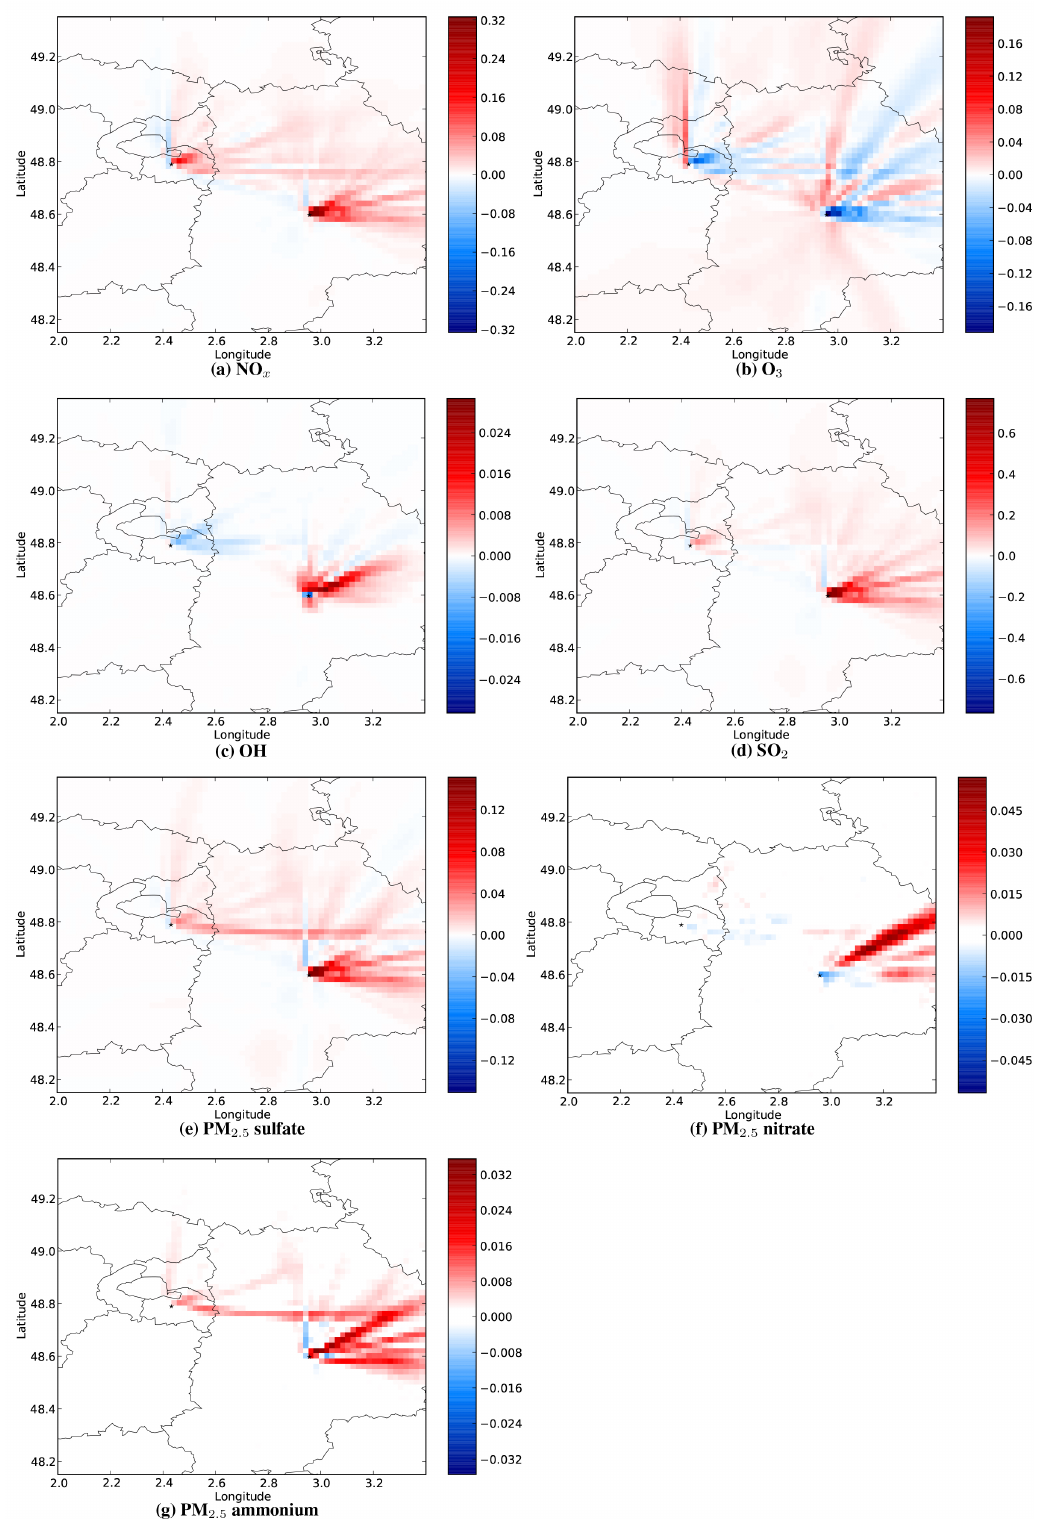
Fig. 4. Differences (PinG – Reference) in mean surface concentrations for 4–29 July 2009 over the Greater Paris domain: (a) NO x (ppb), (b) O 3 (ppb), (c) OH (ppt), (d) SO 2 (ppb), (e) PM 2 . 5 sulfate (µgm − 3 ), (f) PM 2 . 5 nitrate (µgm − 3 ), (g) PM 2 . 5 ammonium (µgm − 3